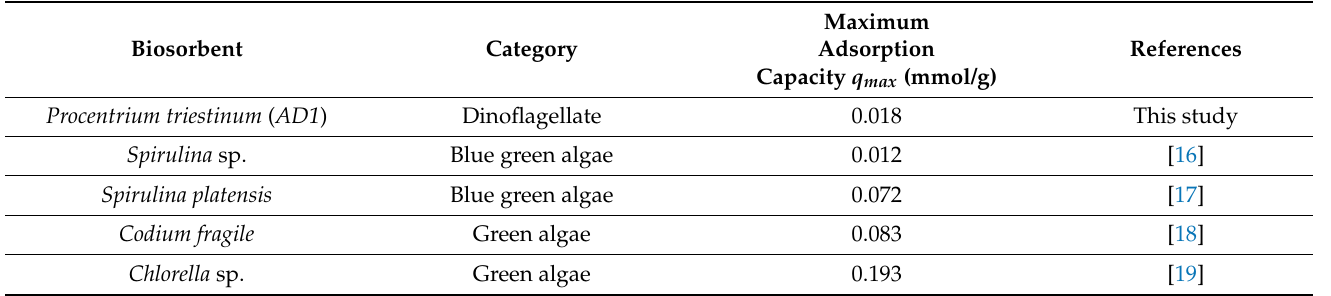
Table 2. Maximum adsorption capacity of AD1 and other